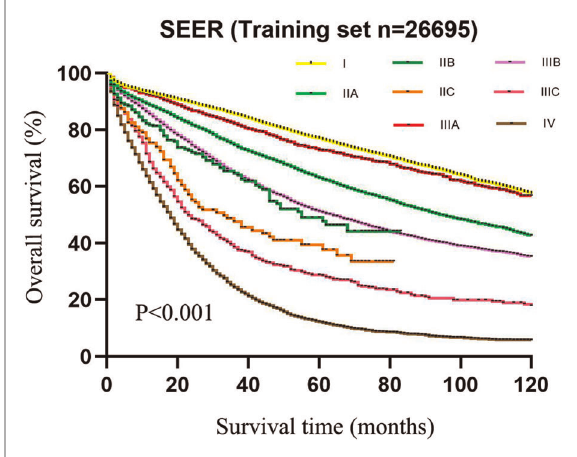
FIGURE 3 The 5-year survival rate of patients in the training set using CRC patients from the SEER database based on the AJCC TNM staging